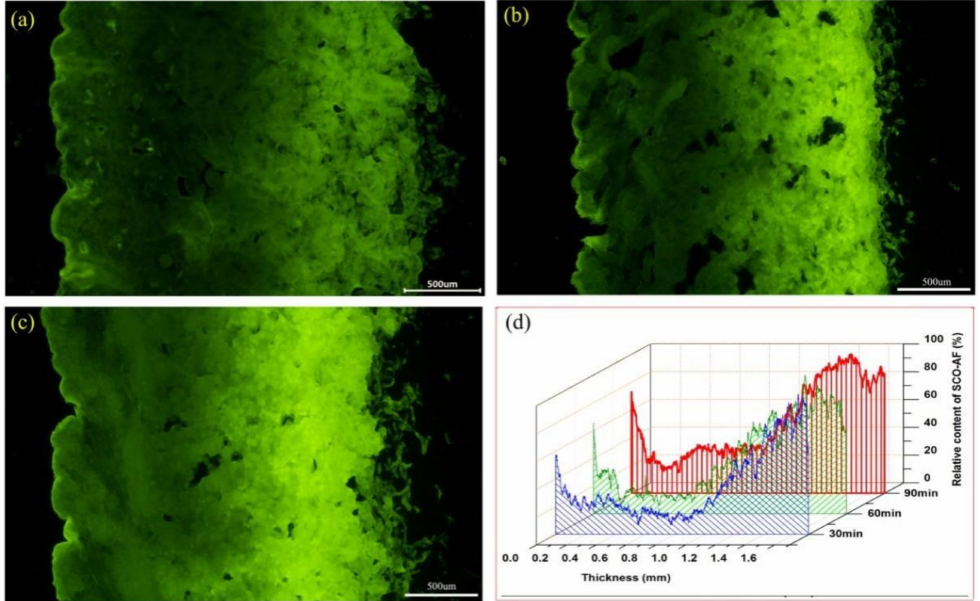
Figure 7. Fluorescence micrographs of AFSCO transferred into leather at different time: ( a ) 30 min, ( b ) 60 min, ( c ) 90 min and ( d ) quantification analysis of fluorescence